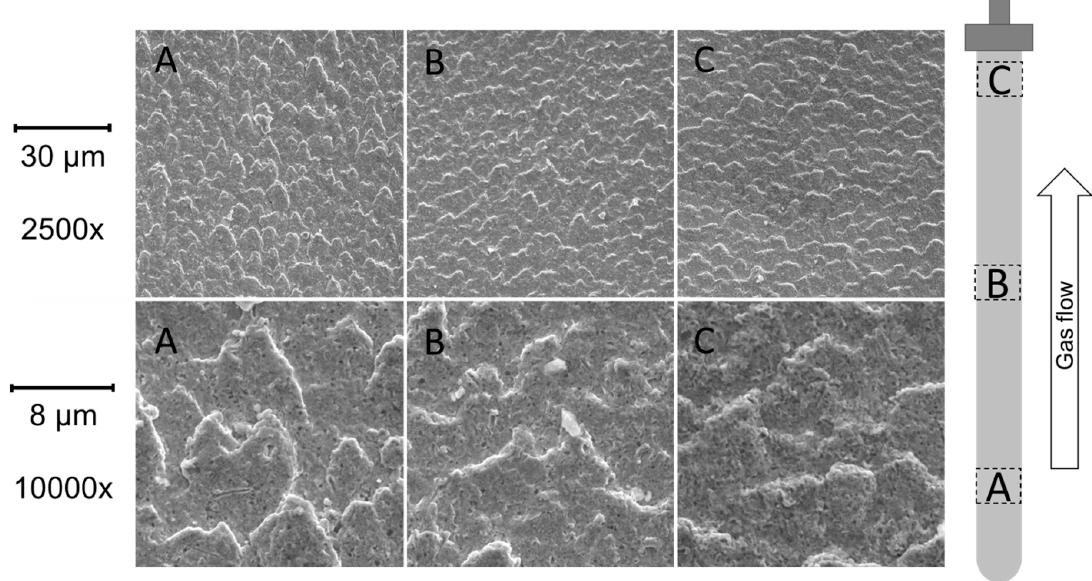
Figure 15. Surface effects on membrane 4b after 1150 h and fluidization up to 500 °C.